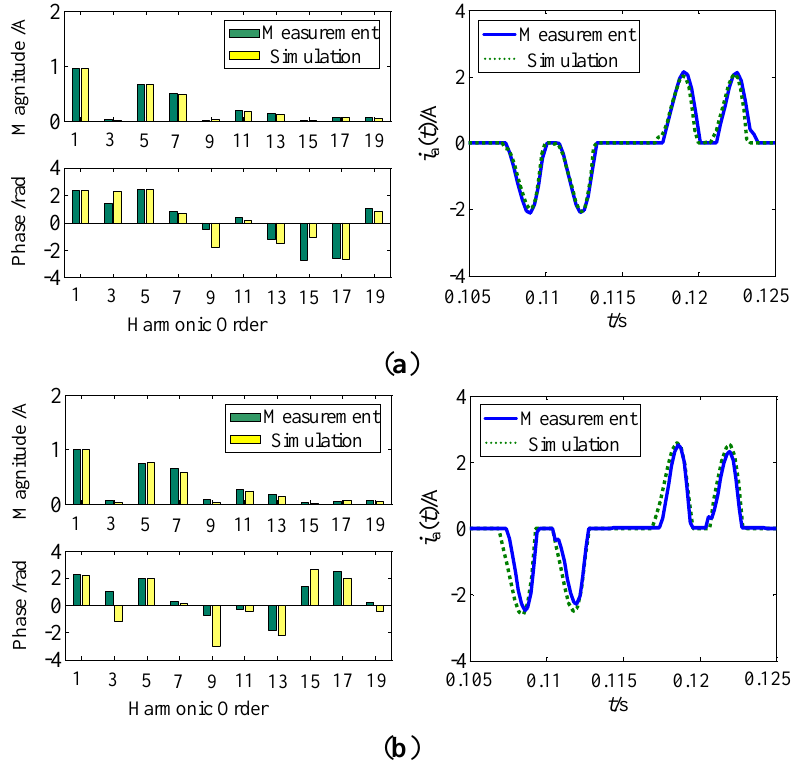
Figure 4. AC current comparison for the charger in discontinuous current mode: ( a ) case 1 and ( b ) case